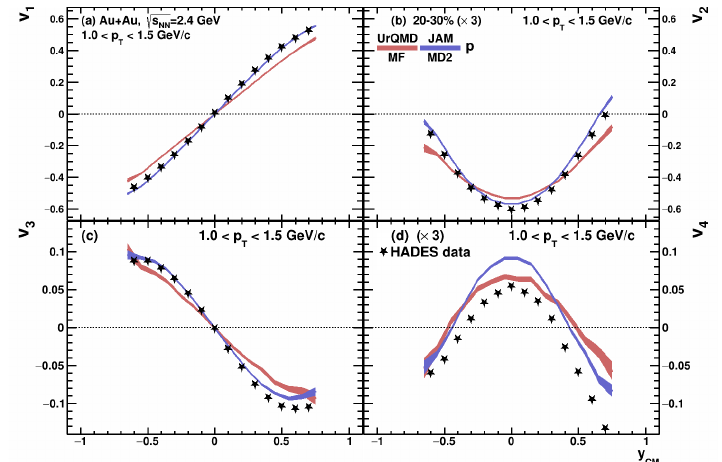
Figure 9. Rapidity ( y cm ) dependence of anisotropic flow coefficients v 1 , v 2 , v 3 and v 4 of protons √ s NN = 2.4 GeV. The black closed symbols denote ( a – d ) in the 20–30% central Au + Au collisions at the published data from the HADES experiment [17]. The red and blue bands represent the results from the mean-field mode of UrQMD and JAM MD2 models, respectively. The uncertainties of the simulated model data are statistical.